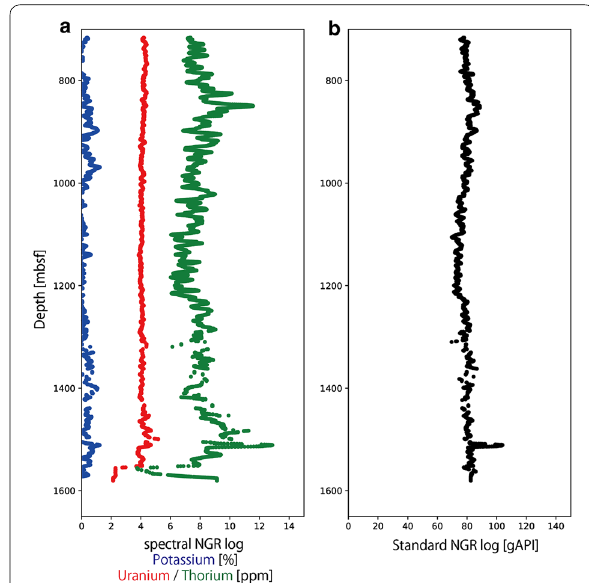
Fig. 8 Gamma Ray log from site C0009. a Results of spectral logging. Blue, red, and green symbols indicate results from potassium, uranium, and thorium. b Standard NGR